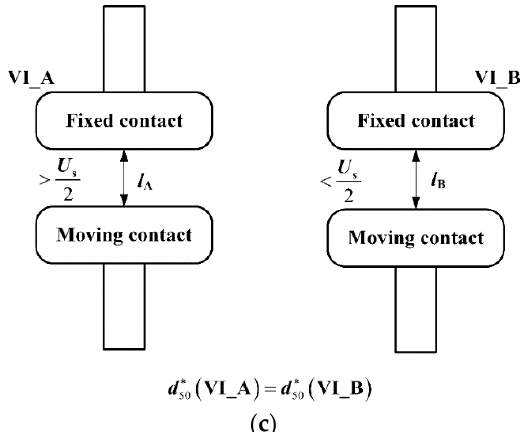
Figure 11. Schematic diagram of the negative effects of the double-break VCBs in terms of the asynchronous property of the mechanical actuators ( a ), the inhomogeneity of the inherent prestrike gaps ( b ), and the unequal voltage-sharing ratio ( c ).